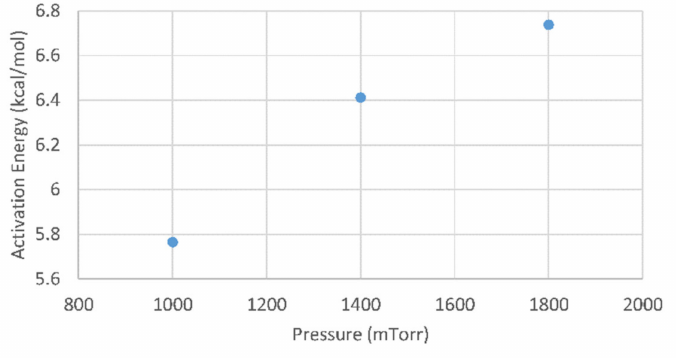
Figure 4. The effective activation energy for PECVD boron films as function of reactor